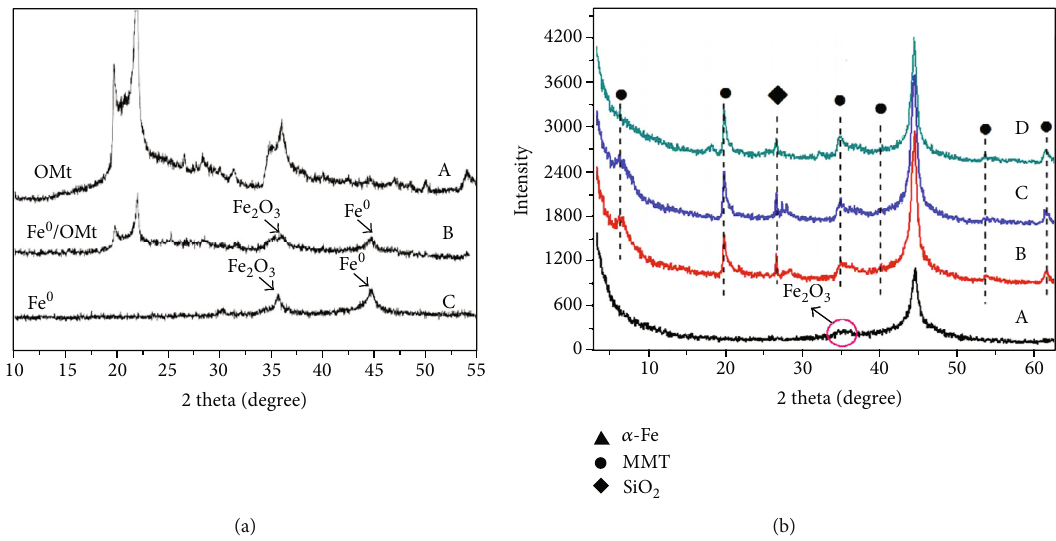
Figure 5: XRD patterns of (a) (A) OMt, (B) OMt-nZVI, and (C) nZVI [26] and (b) (A) nZVI, (B) Mt-nZVI, (C) K-Mt-supported nZVI (K-Mt-nZVI), and (D) starch-stabilized K-Mt-nZVI